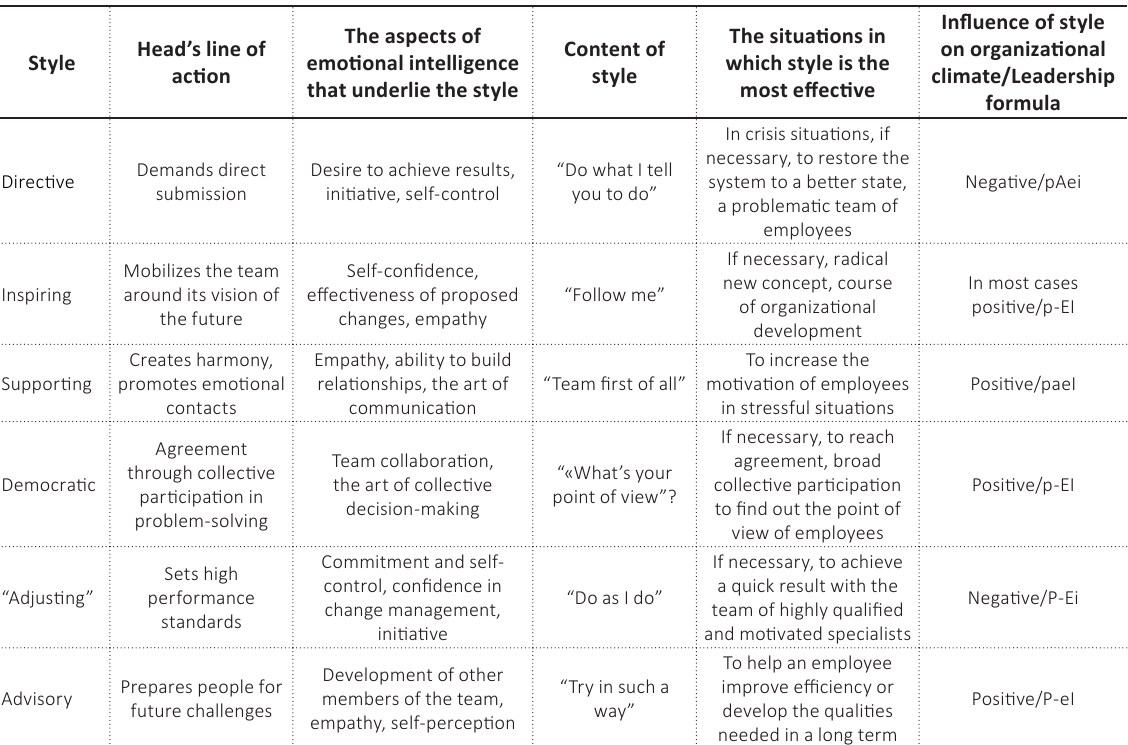
Table 5. Influence of leadership styles on the effectiveness of educational change according to D.